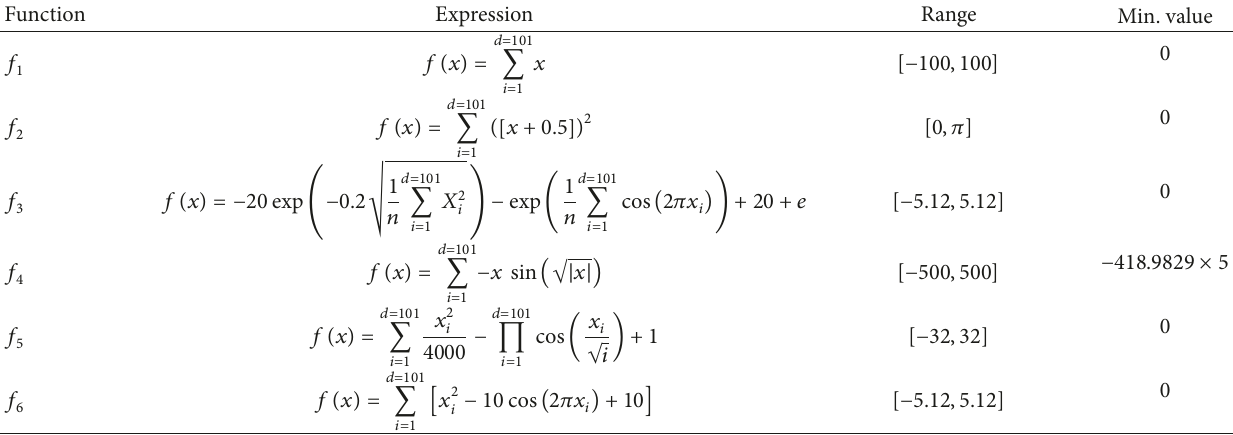
Table 1: Simulation testing functions.